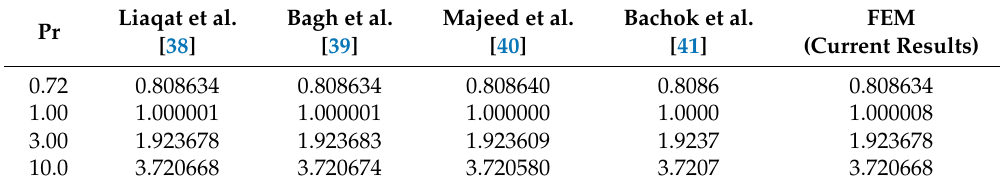
Table 3. Comparison of the Nusselt number ( − θ (cid:48) ( 0 )) for different values of Pr , when all others parameters are zero. Liaqat et al. Bagh et al. Majeed et al. Bachok et al. FEM Pr